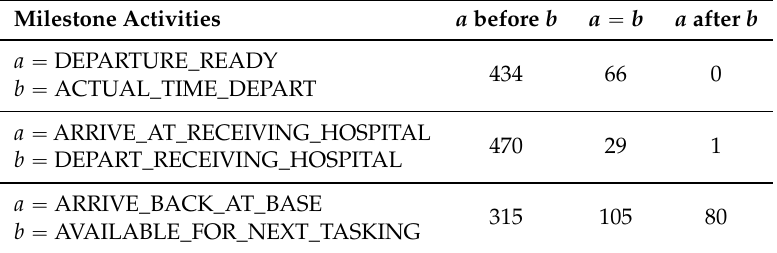
Table 5. RSQ—milestone activity ordering violations.